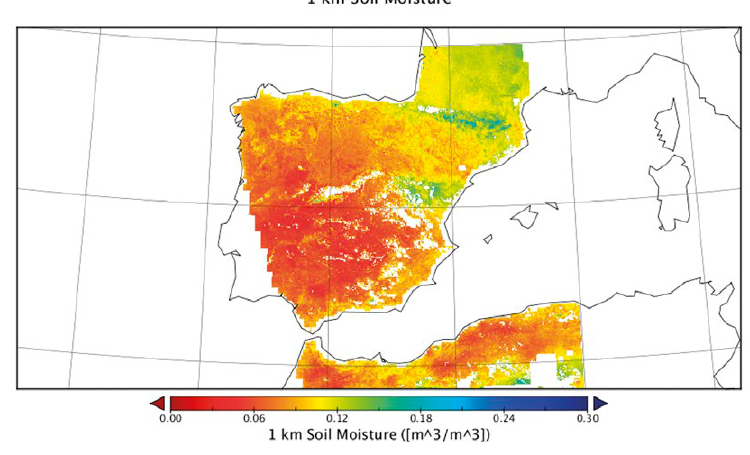
Fig. 17. – SMOS-BEC L4 product from 1 September 2014 (6